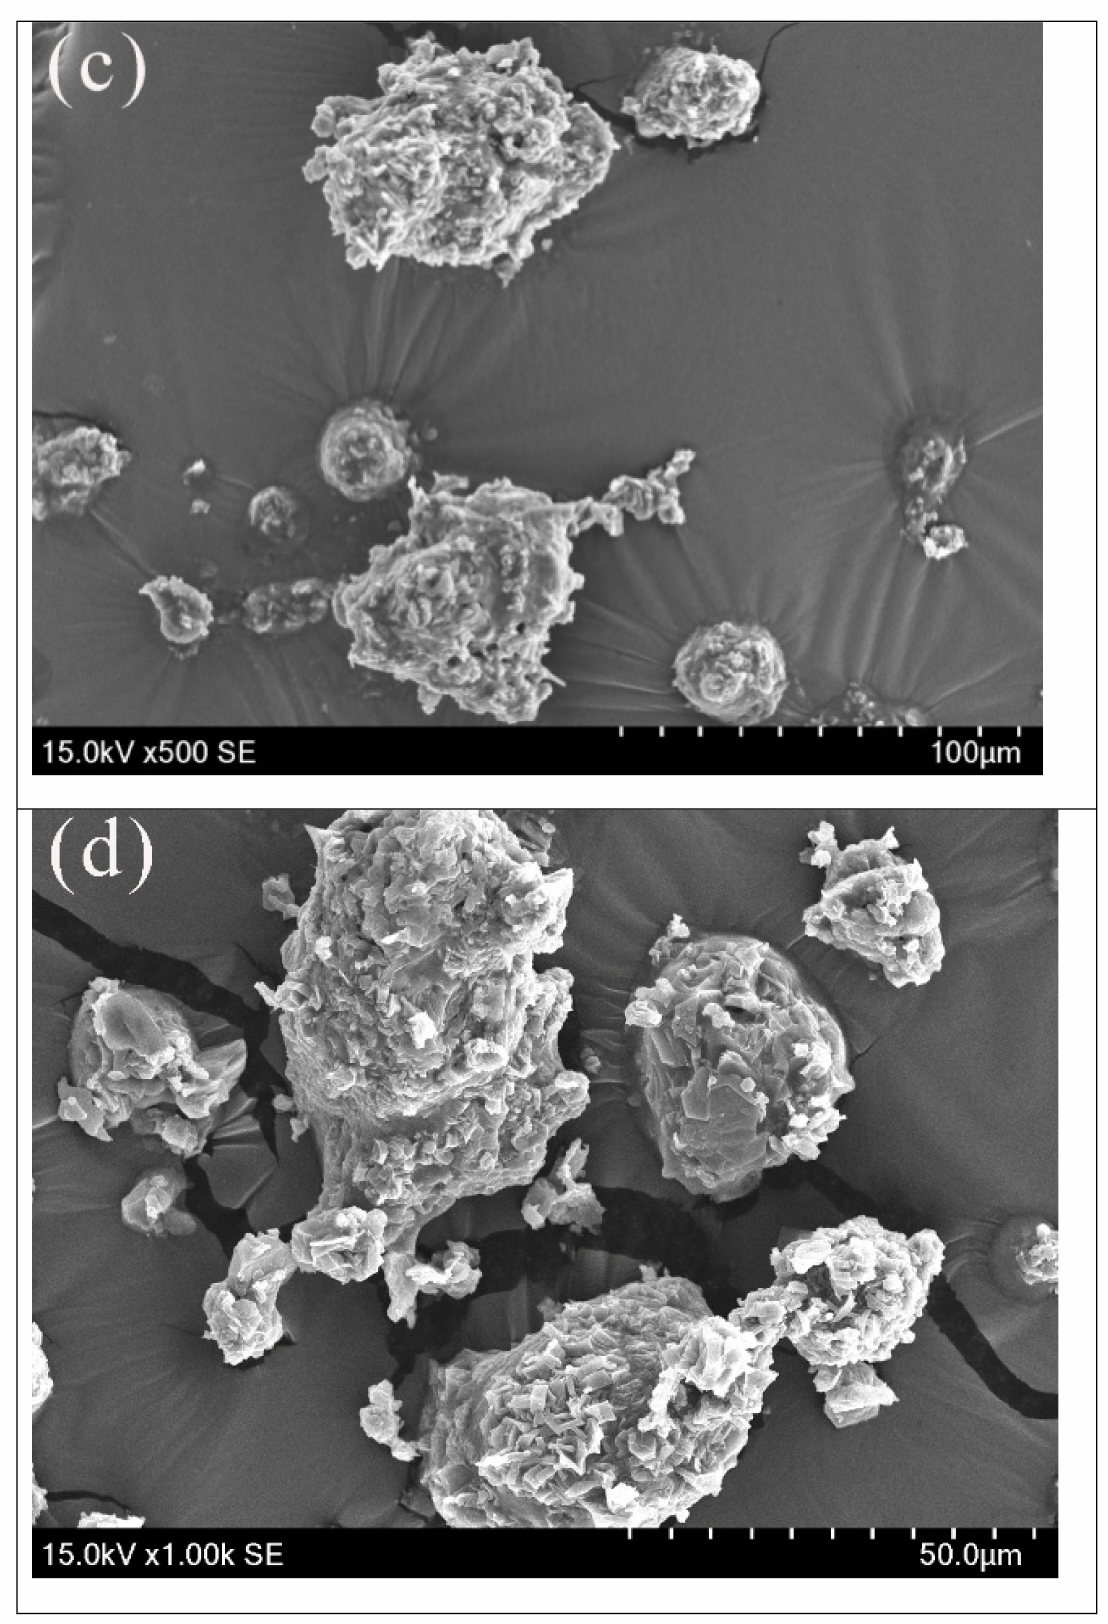
Figure 6. SEM analysis of roasted samples ( a ) raw slag, ( b ) roasted slag in the air, ( c ) roasted slag + ABS in N 2 gas, ( d ) roasted slag + ABS in the